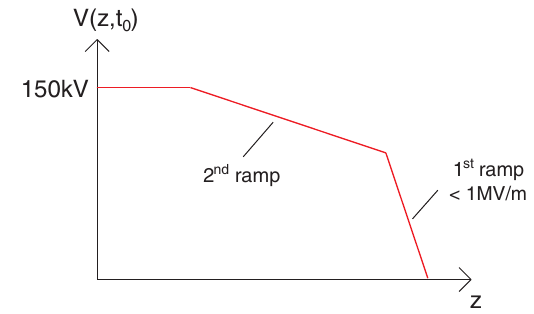
FIG. 2. (Color) A voltage waveform consists of two